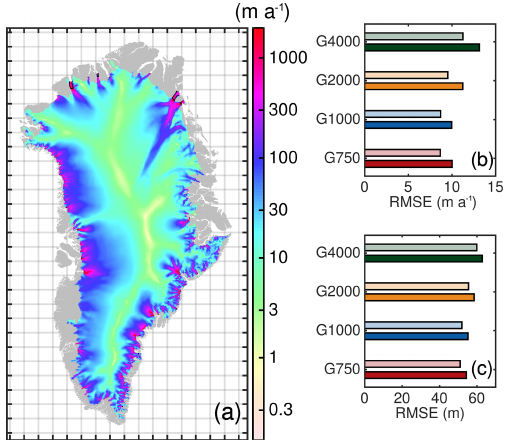
Figure 5. Simulation results and error estimate of model output at the end of the historical run compared to observations. (a) Simu- lated surface velocity of the GrIS (ma − 1 ) from the G750 simula- tion. The grey silhouette shows the Greenland land mask from Bed- Machine v3. Thin black lines show the grounding line. (b) Root mean square error (RMSE) of the horizontal velocity magnitude compared to MEaSUREs. (c) RMSE of ice thickness (not corrected with ctrl) compared to BedMachine v3. In panels (b) and (c) , light and dark colours represent diagnostics at the initialization and end of the historical experiment, respectively. The diagnostics have been calculated on the regular MEaSUREs and BedMachine grids, re- spectively.